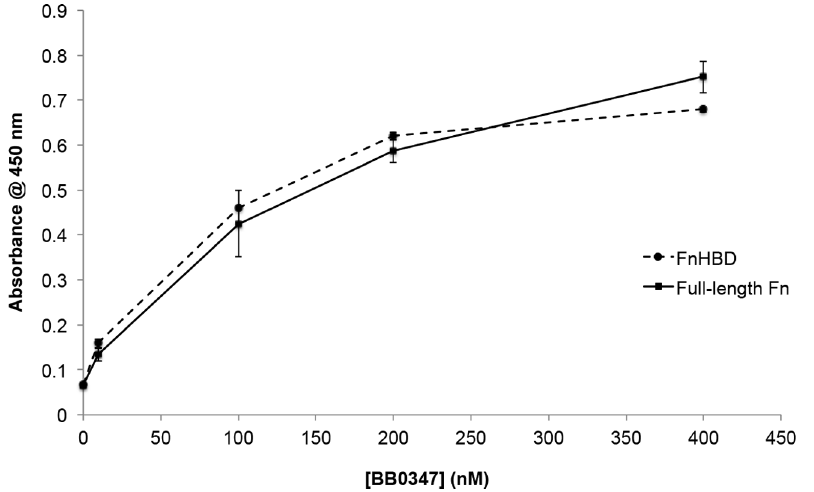
Figure 5. BB0347 interacts with the heparin-binding domain of Fn. An ELISA was performed analyzing the binding of recombinant BB0347 to both full-length Fn and the heparin-binding domain of Fn. A dose-dependent response in the binding of rBB0347 to the FnHBD was observed. No difference was observed between the interaction of BB0347 with either protein. The results are representative of three independent experiments with at least three replicates for every value. Error bars indicate 6 SEM.